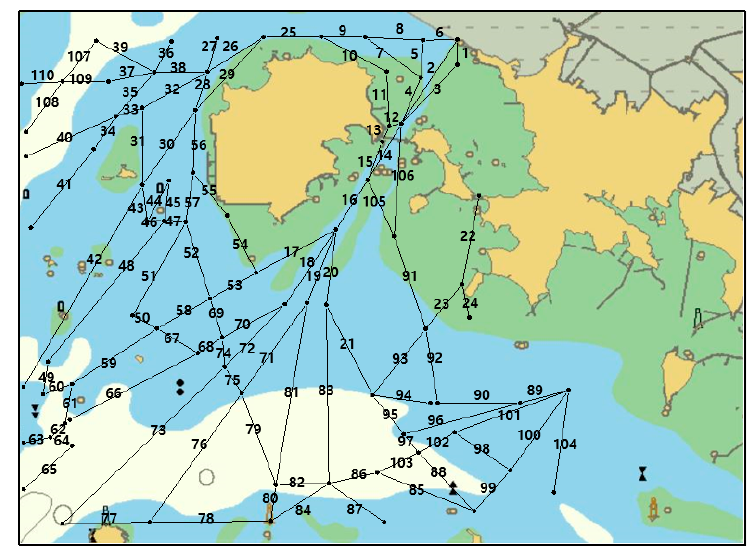
Figure 11. Target waters to which 110 legs were applied according to the traffic flow.